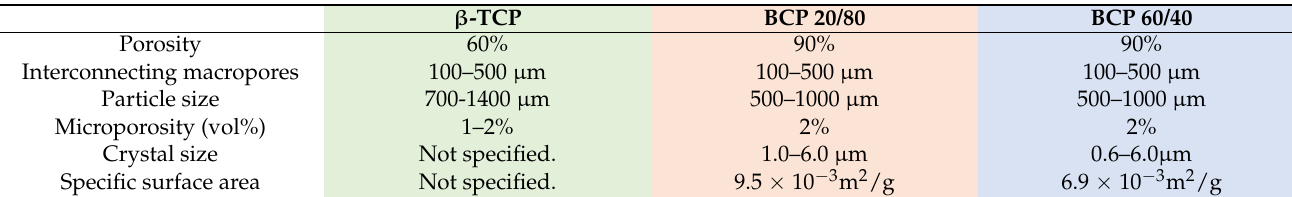
Table 1. Physical properties of three types of calcium phosphate ceramics, as specified by the manufacturers. β -TCP— β - tricalcium phosphate; BCP—biphasic calcium phosphate; HA—hydroxyapatite.